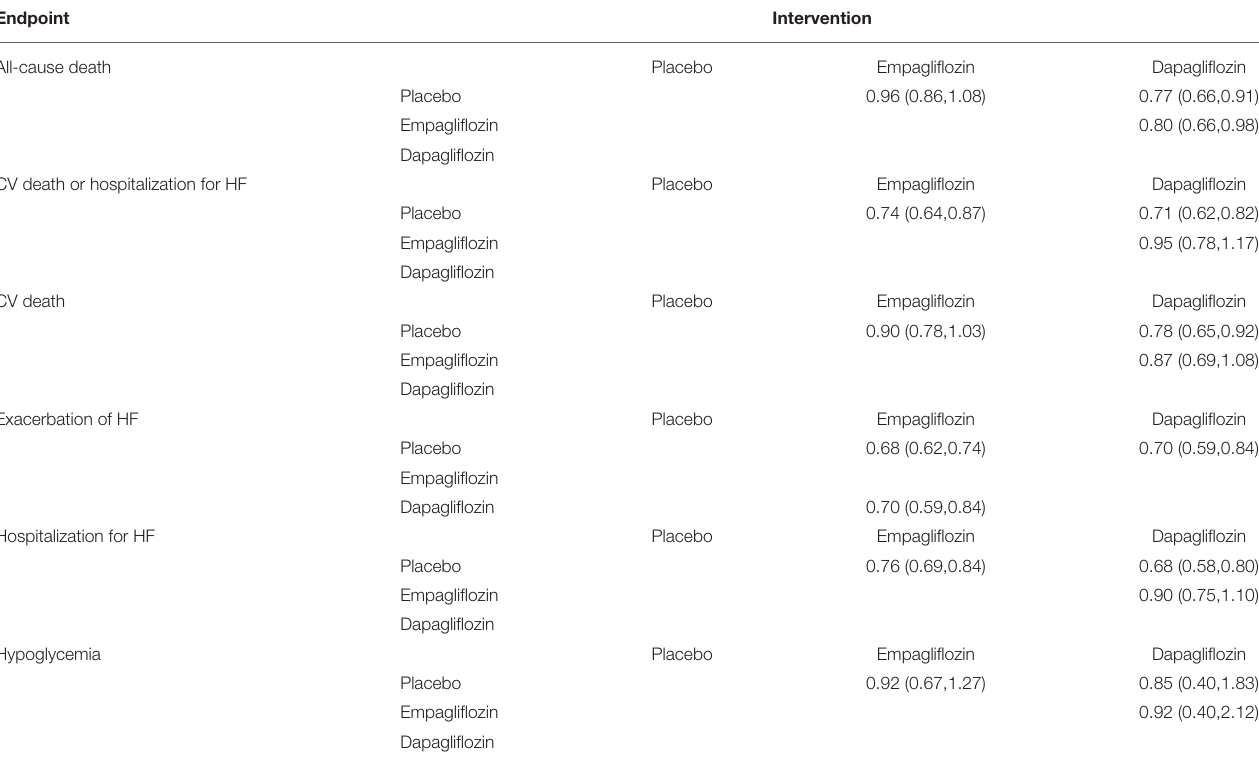
TABLE 2 | Network meta-analysis matrix of